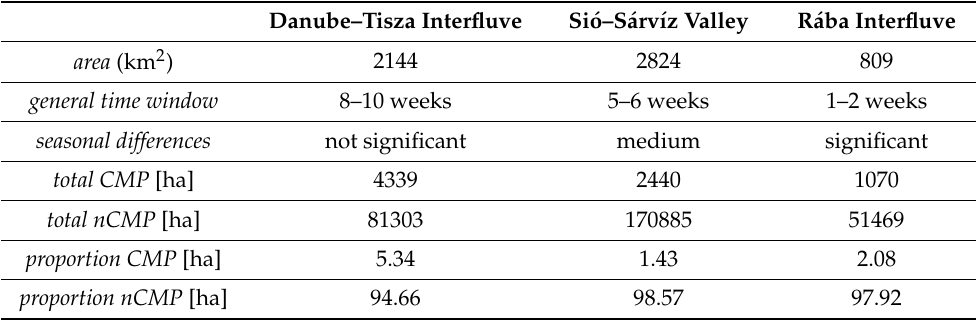
Comparison of the cropmark investigation circumstances and the proportions of CMP/nCMP of the study